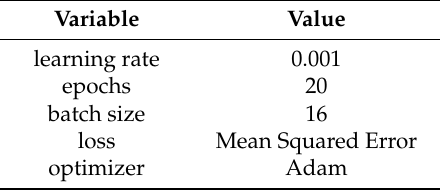
Table 2. Training details about self-attention-based